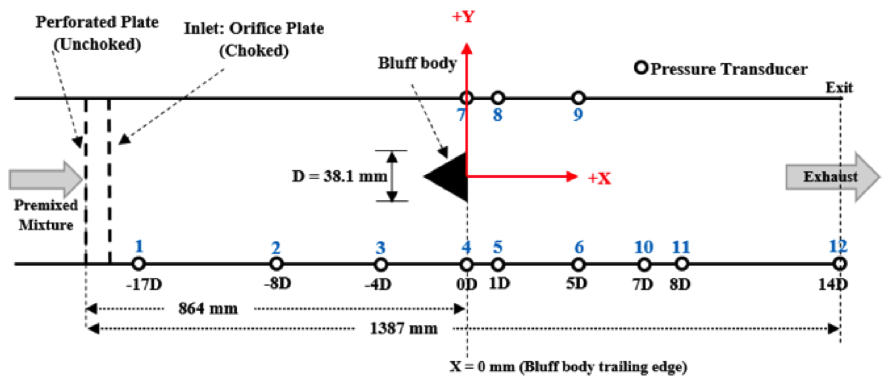
Figure 7. Schematic of the bluff body combustion chamber with locations of pressure transducers. The trailing edge of the symmetric bluff body is assigned to be at downstream locations being positive. Note that transducers 7, 8, and 9 are placed opposite to 4, 5, and 6, respectively. A detailed explanation of imaging optics and measurement techniques can be found in the Ref. [42]. Here, we confine our analysis to measurements from transducers